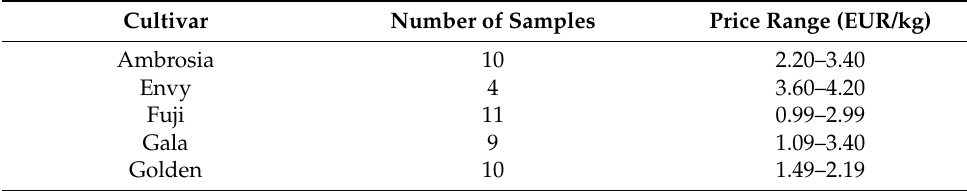
Table 1. Features of apple samples used in the present